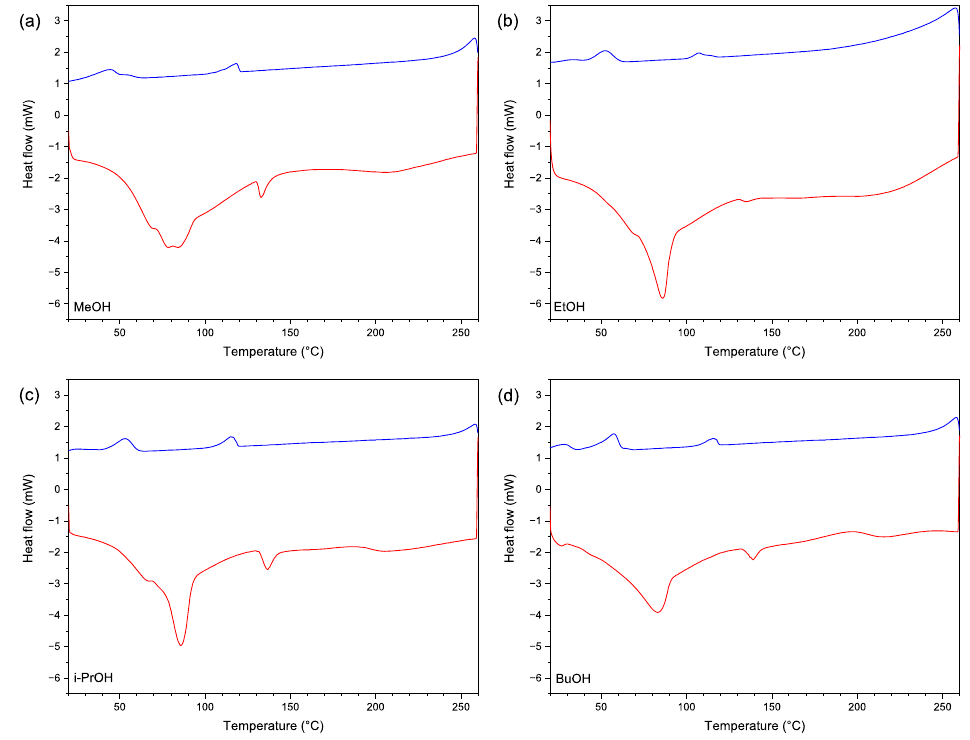
Figure 2. DSC thermograms for ( a ) MeOH, ( b ) EtOH, ( c ) i-PrOH, and ( d ) BuOH adhesive samples (the red curve represents heating from 20 °C to 260 °C and the blue curve represents cooling from 260 °C to 20 °C).